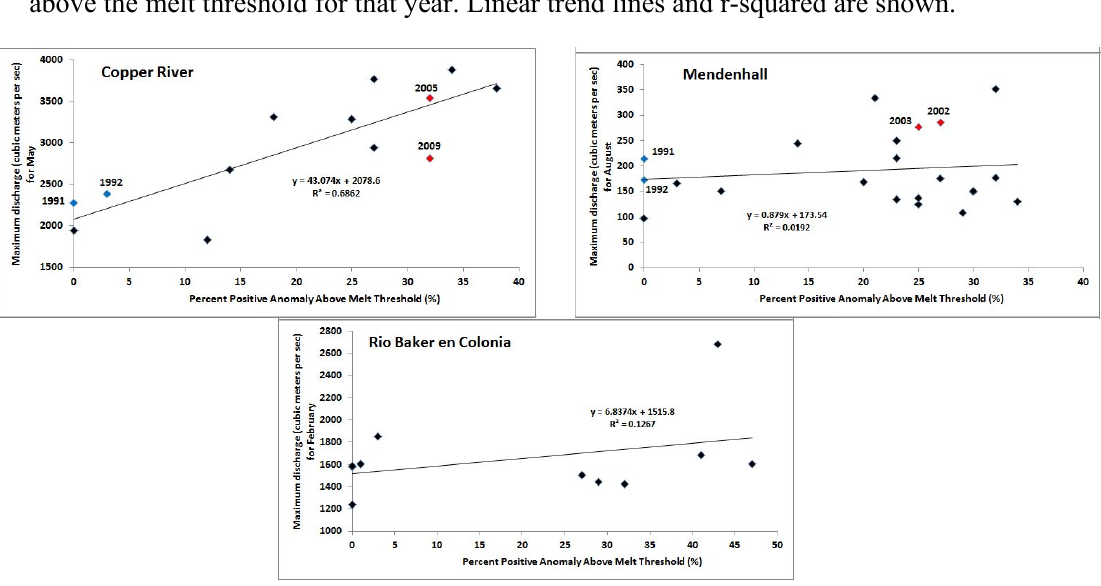
Figure 10. Maximum discharge (cubic meters per second) for months of typical high melt runoff (May for Copper River in Alaska, August for glacial Mendenhall River in Alaska, and February for Rio Baker in Chile) plotted against the percentage of positive anomalies above the melt threshold for that year. Linear trend lines and r-squared are shown.